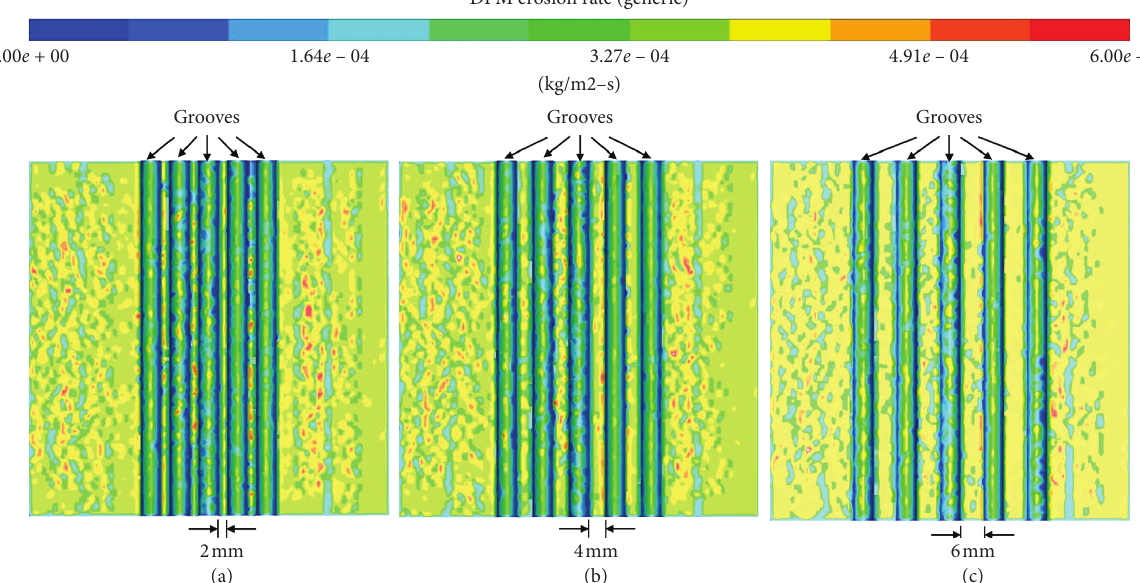
Figure 7: Wind erosion rate distribution on the grooved wall surfaces at the impact angle of 90 ° and wind velocity of 19m/s under different groove spacings: (a) 2mm; (b) 4mm; (c) 6 mm.